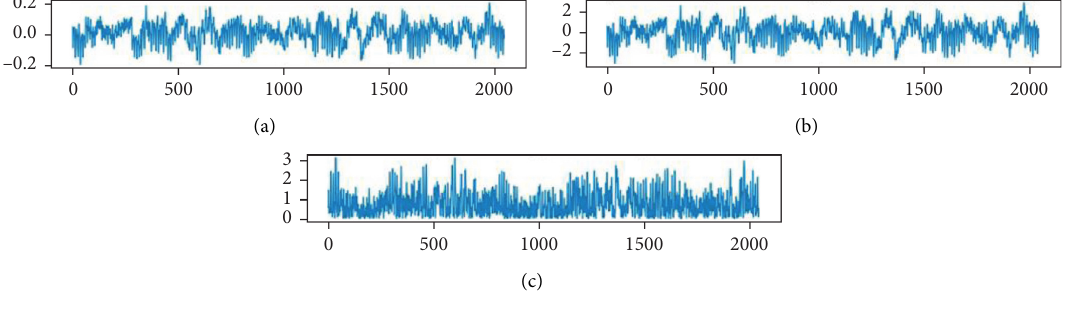
Figure 8: Normal state.